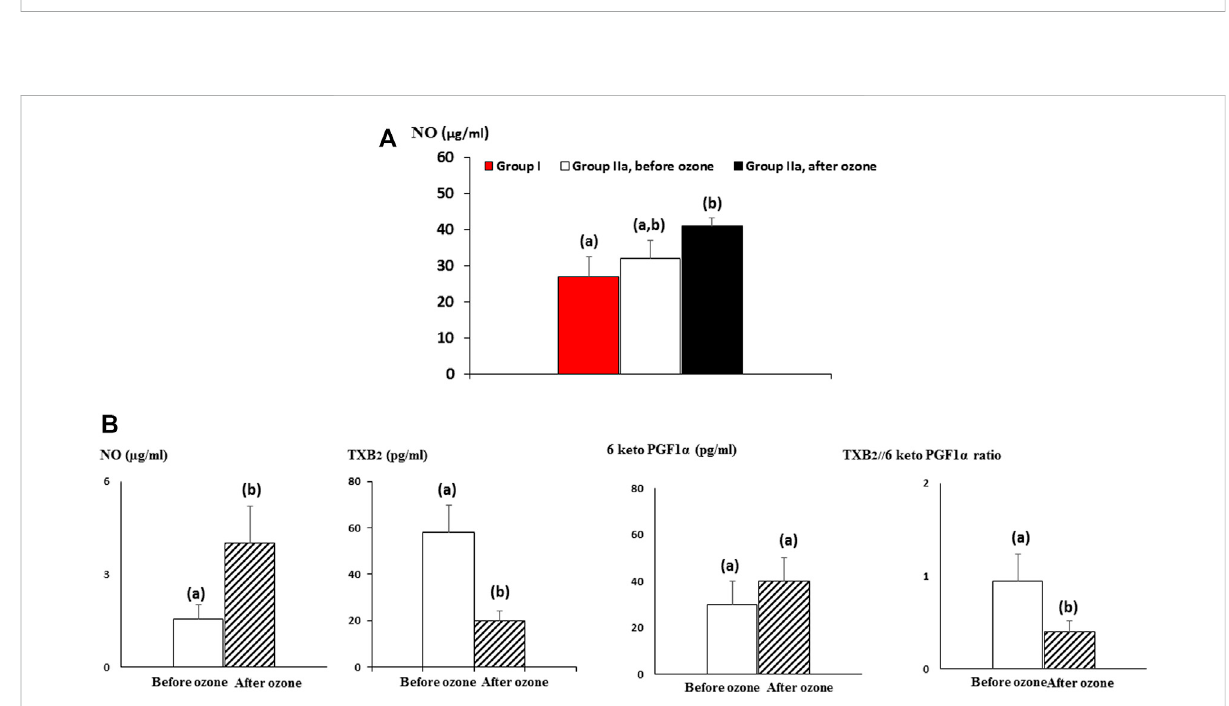
FIGURE 3 Medical ozone effects on vasoactive mediators in older patients (60 – 70 years old). (A) NO (nitric oxide) levels in rheumatoid arthritis + comorbiditiespatients. (B) NO,TXB2(thestablemetaboliteofTXA2),and6-ketoPGF1 α (thestablemetaboliteofprostacyclin)plasmaconcentrations in bronchial asthma patients before and after ozone treatment. The data re fl ecting NO, TXB2, and 6-keto PGF1 α plasmatic levels are the mean ± S.E.M. of each group. Mean values with different letters indicate signi fi cant differences ( p < 0.05) between